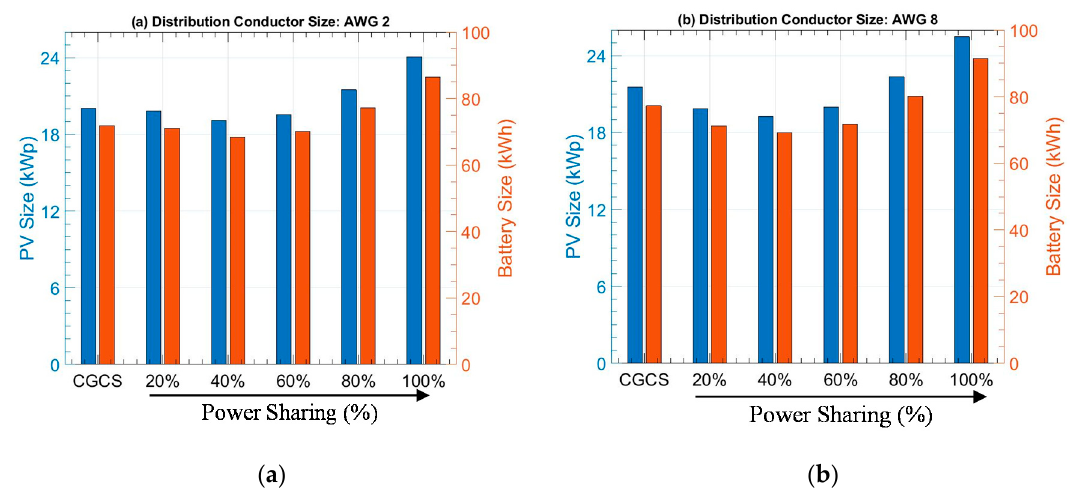
Figure 14. ( a ) PV and battery sizing comparison between CGCSA and DGDSA with various power-sharing levels with AWG 2 conductor ( b ) time-varying distribution losses of CGCSA vs. DGDSA at variable power-sharing with AWG 8 conductor.